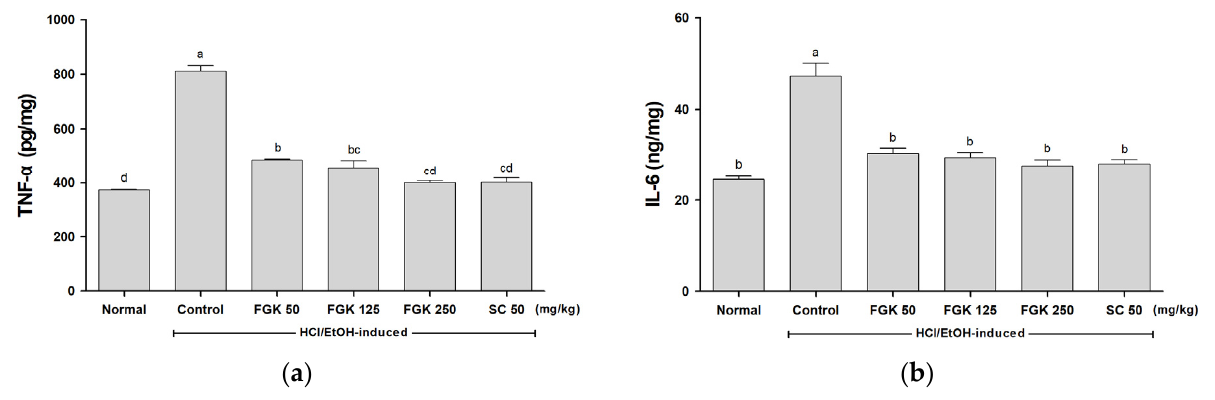
Figure 7. Effects of fermented gold kiwi (FGK) on pro-inflammatory cytokine concentrations in the stomach tissues of HCl/EtOH-induced rats: ( a ) TNF- α and ( b ) IL-6. Normal, rats treated with only DW; Control, rats treated with HCl/EtOH; SC 50, rats treated with HCl/EtOH and sucralfate; FGK, rats treated with HCl/EtOH and FGK (50, 125, and 250 mg/kg). Results are expressed as mean ± SEM (N = 8). a–d Different labels were significantly different at p < 0.05 between treatments, as determined by Tukey’s analysis.